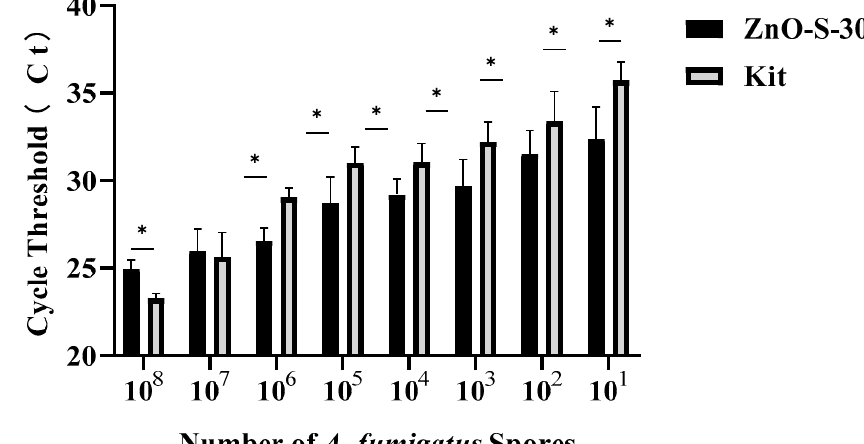
Figure 4. Performance evaluation of the DNA extraction assay using either the ZnO-based fungal DNA isolation assay or the commercial kit assay with A. fumigatus spore concentrations ranging from 1 to 10 8 cells / 100 µ L by comparing the cycle threshold (Ct) of real-time PCR. Error bars indicate standard deviation from the mean, based on at least three independent experiments. * p < 0.05 .